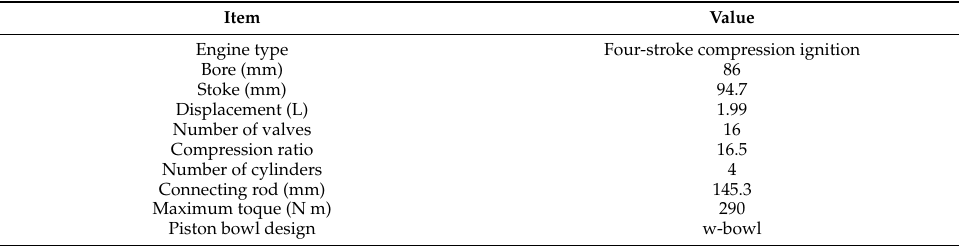
Table 1. Engine specifications.